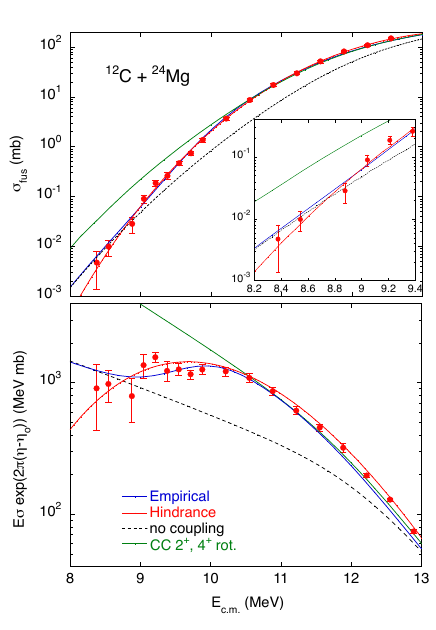
Figure 3. Measured excitation function (top) and S factor (bottom) of 12 C + 24 Mg compared to